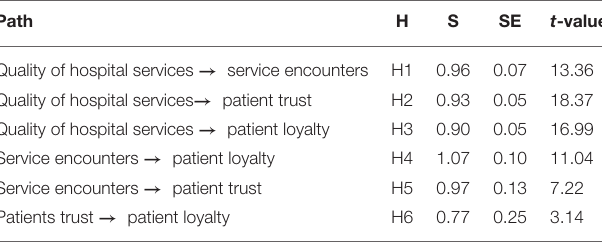
TABLE 11 | Estimated values of hypothetical path parameters of theoretical structure model ( n = 483). Path H S SE t -value Quality of hospital services → service encounters H1 0.96 0.07